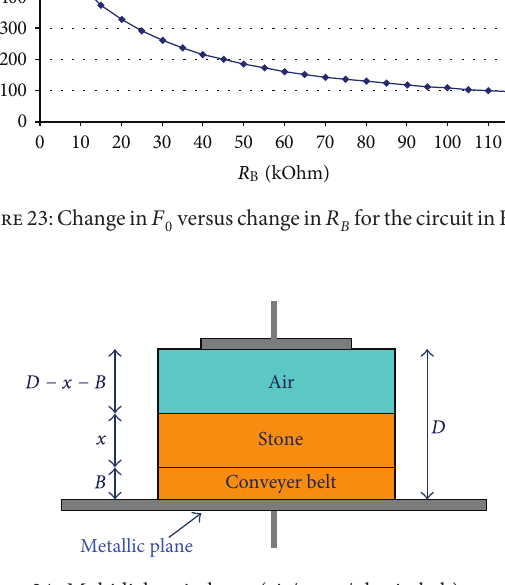
F 24: Multidielectric layer (air/stone/plastic belt) capacitive sensor inside the marble